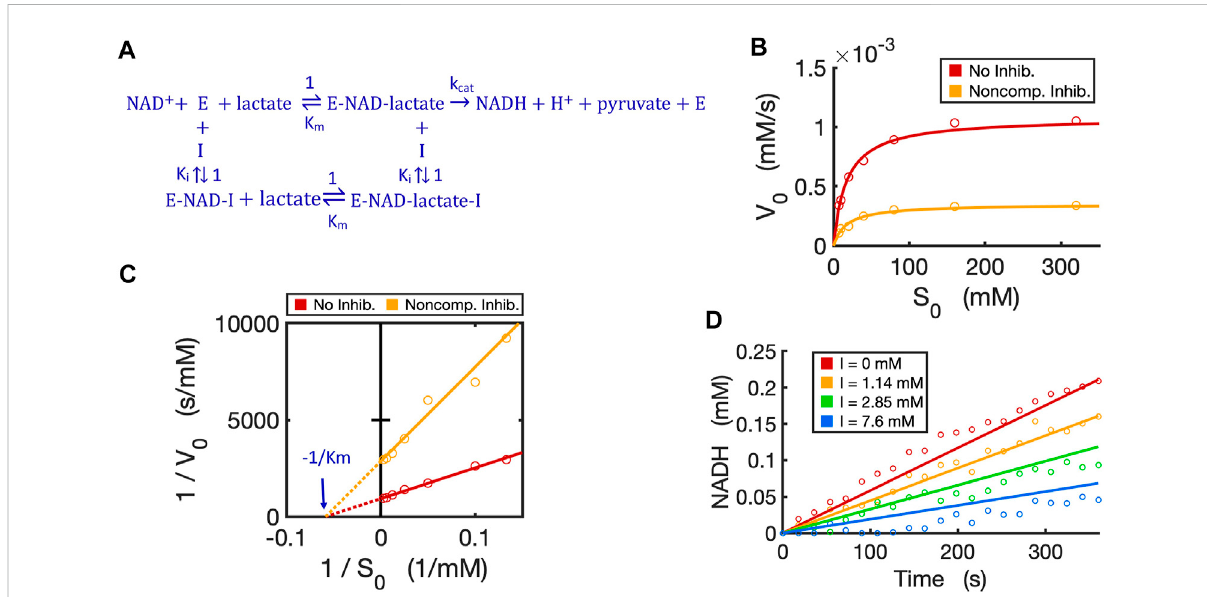
FIGURE 10 Circuit modeling ofnon-competitive inhibition ofLDH by oxamate. (A) The reaction scheme ofnon-competitive inhibition against LDH, where the inhibitor I is oxamate. For simpli fi cation, the initial catalysis can be viewed as a directional reaction, though the LDH reaction is known to be reversible; the fast binding step of NAD + to enzyme is neglected in this reaction scheme. (B) Simulation curves of V 0 versus S 0 fi tted to measured experimentaldata intheabsenceandpresenceofoxamate(7.6 mM), whenE 0 =5.0 nM. (C) Lineweaver-Burkplotshowinglinearized curves of 1/V 0 versus1/S 0 withandwithouttheinhibitor,whichhavethesame X -interceptof-1 /K m . (D) Themodelcurvesofproductdynamicsovertimewith varyinginhibitorconcentrations fi ttedtoexperimentaldatapoints(whenS=80 mM,E 0 =3.3 nM).Allsimulationcurvesareobtained